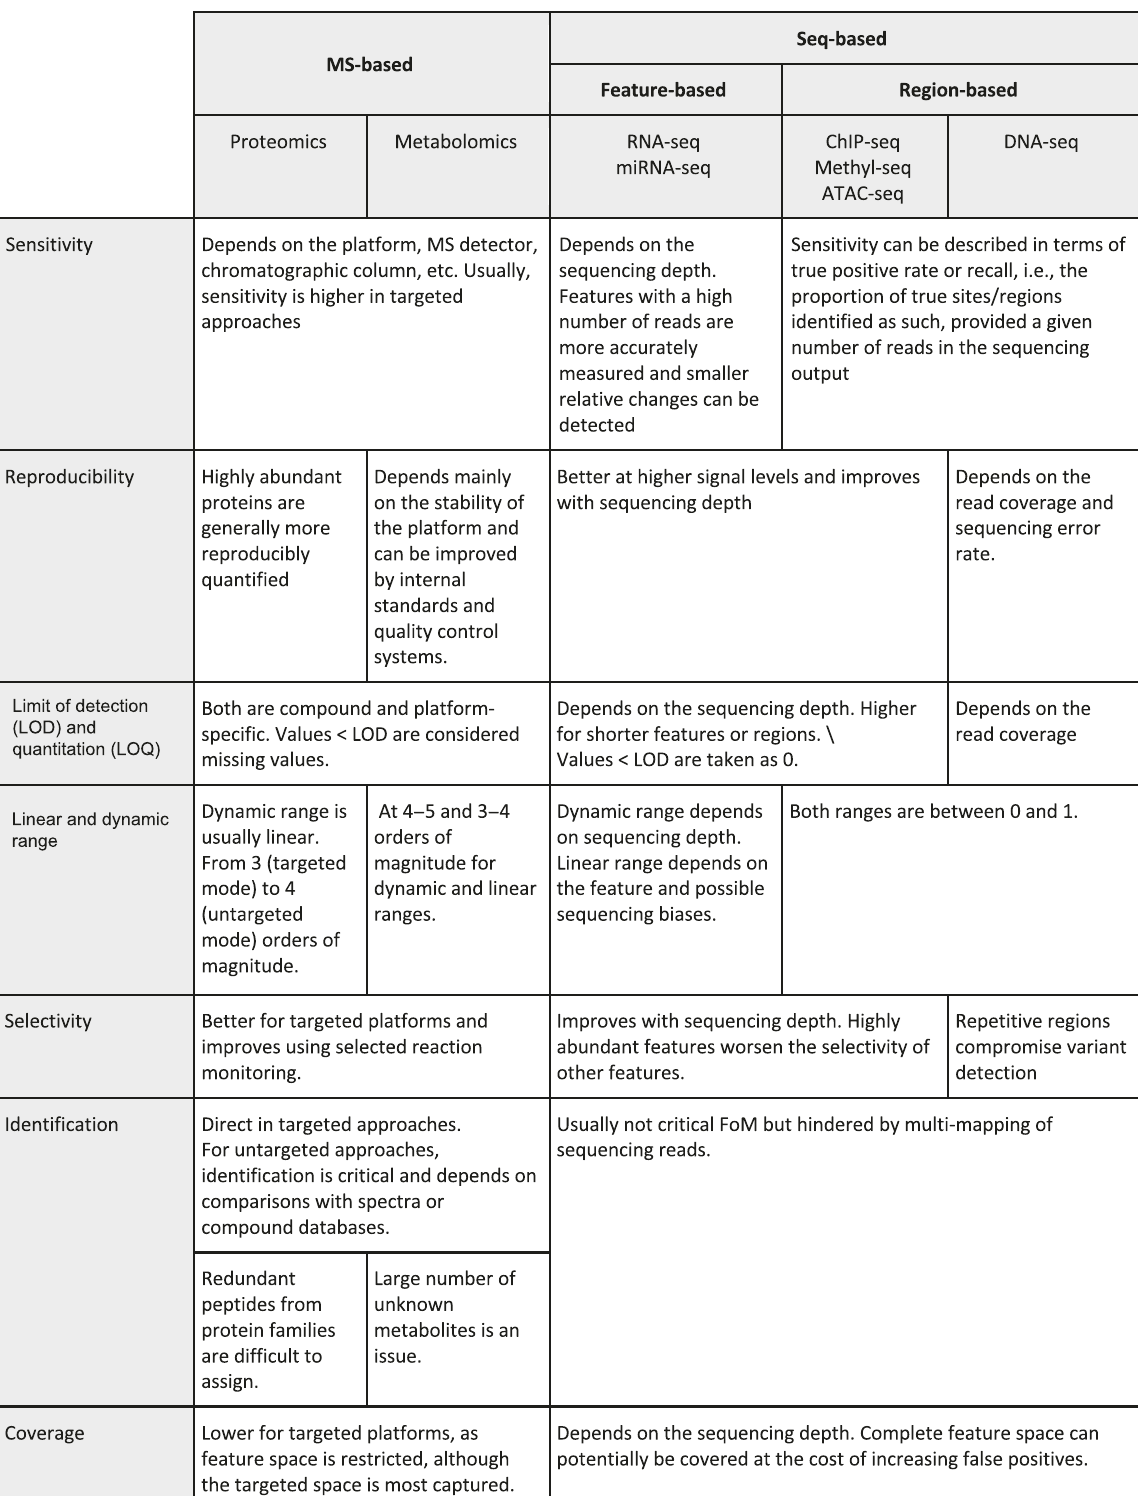
and a low number of nuclei change energy status, leading the detection of only abundant metabolites and lower sensitivity than liquid chromatography (LC) – MS or gas chromatography (GC) – MS. NMR is capable of detecting ~50 – 75 compounds in human bio fl uid, with a lower sensitivity limit of 5 µmolar (ref. 25 ),